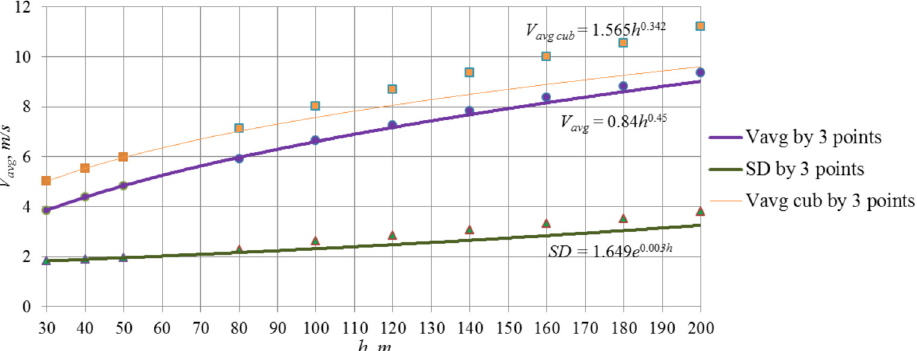
Fig. 3. Approximation curves for the measured values of wind speed V avg , V avg cub (m/s), and for the standard deviation, SD , depending on height h by three points for heights of 30, 40 and 50 (m) above